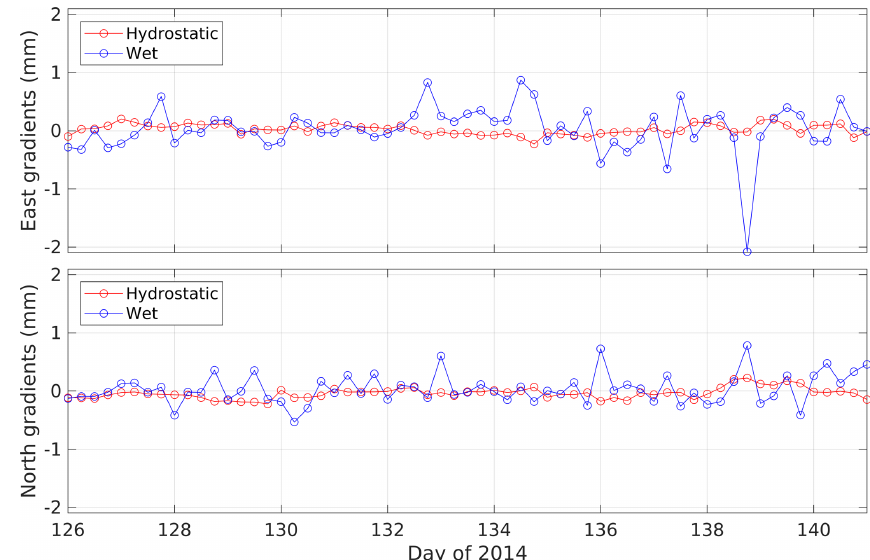
Figure 14. Time series of ECMWF hydrostatic and wet gradients during the CONT14 campaign.